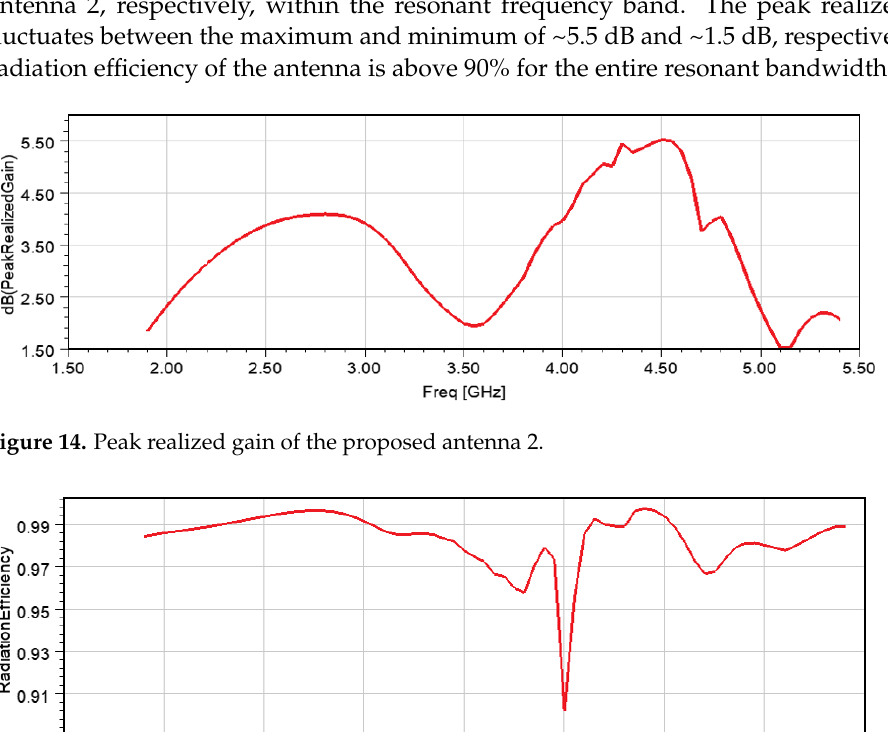
Figure 13. Reflection coefficient (S 11 ) of the proposed antenna 2.